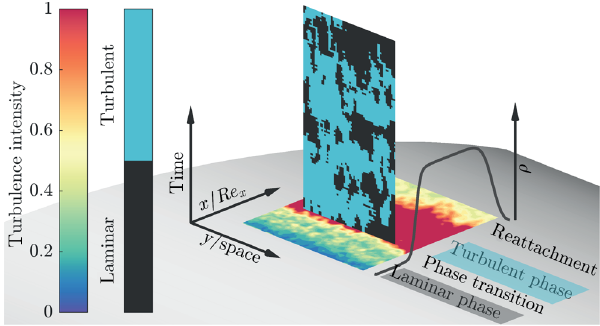
FIG. 3. Illustration of measured and computed quantities. The plane of space and the control parameter (Re x ) is formed by the airfoil ’ s spanwise and chordwise directions, where Re x ¼ Re ð x; u ∞ Þ is based on the distance x from the leading edge and the inflow velocity u ∞ . Here, Re x provides a measure for the flow ’ s likelihood to undergo transition from laminar flow into a LSB and, therefore, serves as a control parameter. The presence of a LSB is indicated by means of turbulence intensity (TI) exceeding a certain threshold denoted as turbulent phase. The instantaneous turbulence intensity is derived from 10 temporally consecutive velocity fields at one respective position Re x in a plane crossing the laminar separation bubble. Transition from laminar flow into the LSB happens after turbulent clusters merge significantly. At this critical point Re , characteristic turbulent c clusters occur, depicted as an evolution in time (vertical plane). Averaging over time at each position Re x , the fraction of turbulent cells, ρ , is shown next to the plane of TI. Following ρ in the streamwise direction, transition from the laminar boundary layer flow into the LSB and subsequent reattachment are obvious. The first phase transition represents the LSB ’ s onset, which is important for our